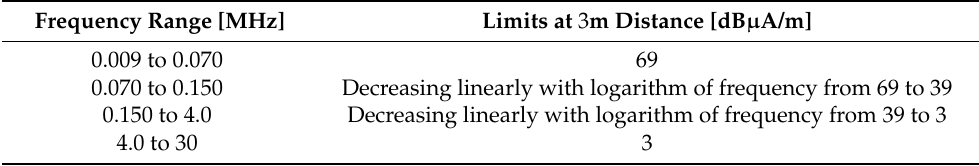
Table A5. CISPR 14-1 Standard (EMC-Requirements for household appliances, electric tools and similar apparatus, Part 1: Emission)